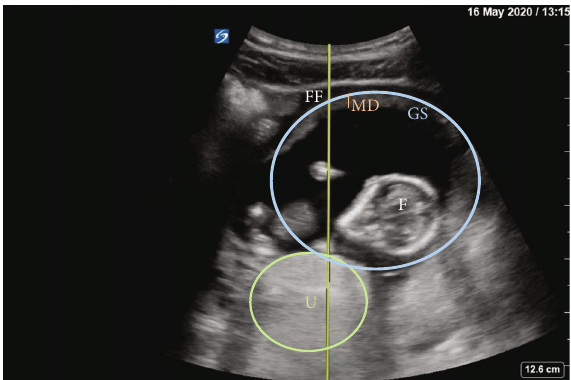
Figure 2: Bedside TAUS on visit 2. FF =free fl uid; MD =mantle distance; GS =gestational sac; F=fetus; U=uterus.